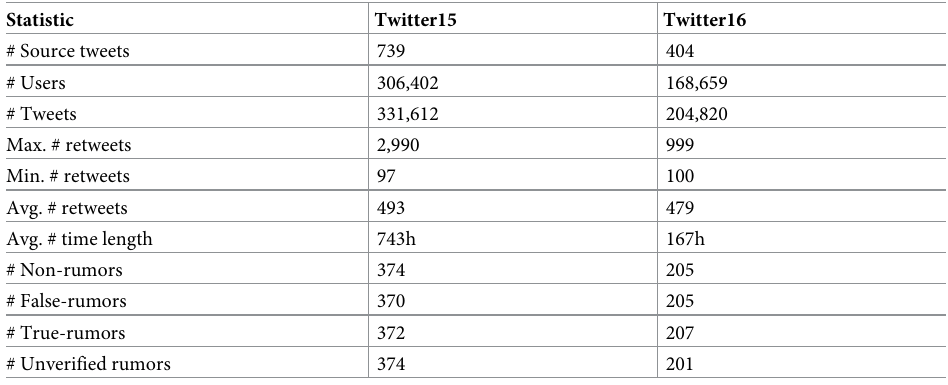
Table 1. Statistics of the